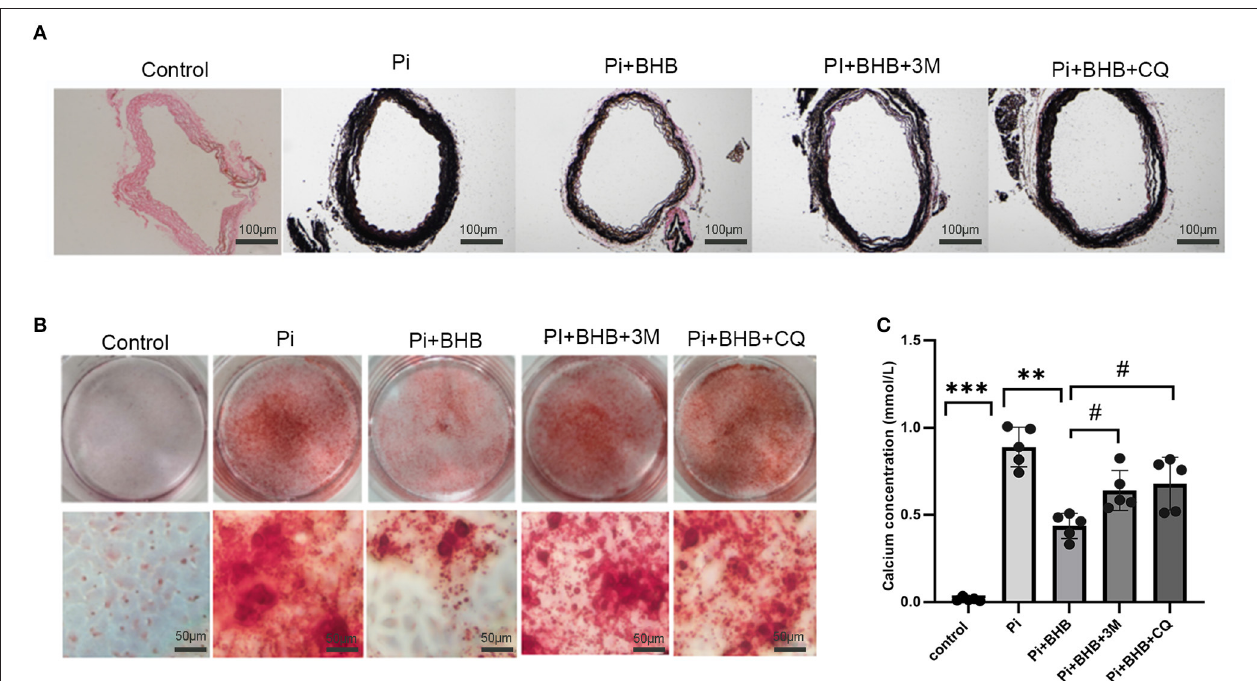
FIGURE 5 | Autophagy inhibitors counteracted the protective effect of β -hydroxybutyric acid (BHB) on vascular calcification. (A) Von Kossa staining of arterial rings. (B,C) Alizarin Red S staining and calcium deposition analysis of vascular smooth muscle cells (VSMCs). Scale bar: 50 µ m. * P < 0.05, ** P < 0.01 vs. VSMCs treated with Pi alone; # P < 0.05 vs. VSMCs treated with Pi +